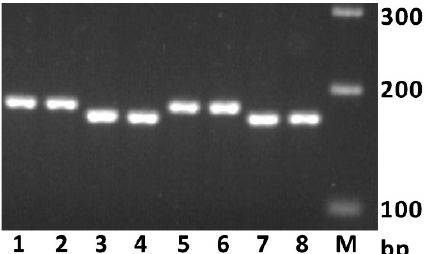
Figure 1. Electrophoresis of the PCR products obtained using primers pGS2-A1-F/R. The lanes represent the following wheat accessions: 1, 2—Caphorn; 3, 4—Nekota; 5, 6—Crimson; 7, 8—Tandem. M—DNA size standard (M-100, Syntol).